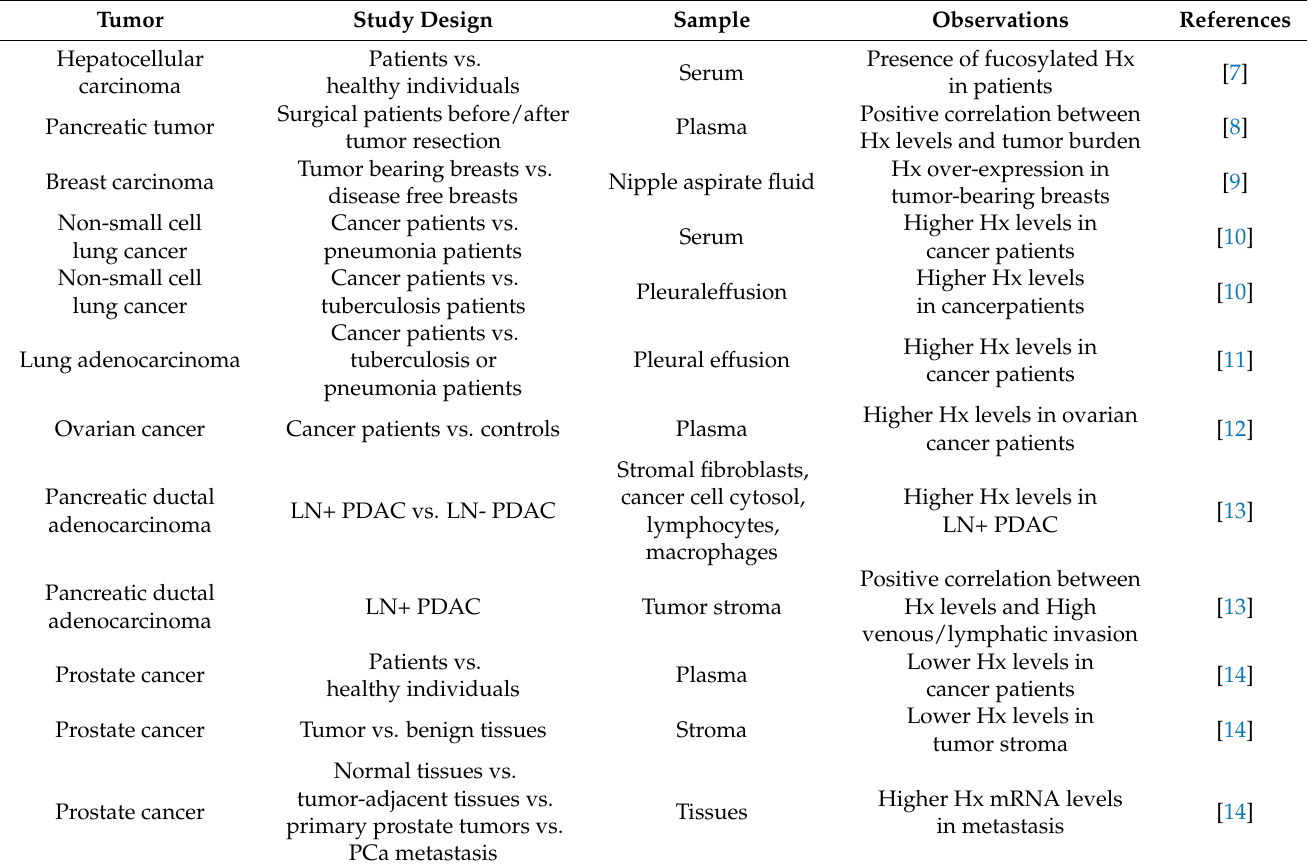
Table 1. Hx as a cancer